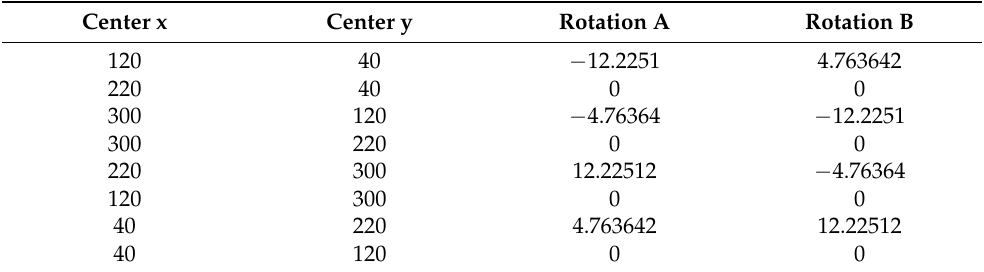
Table 3 tabulates the positions and re-orientations. Table 3. Location and re-orientation of specimen CA_F at edge positions. Rotations A and B signify the counterclockwise rotation about the x- and y-axis, respectively.